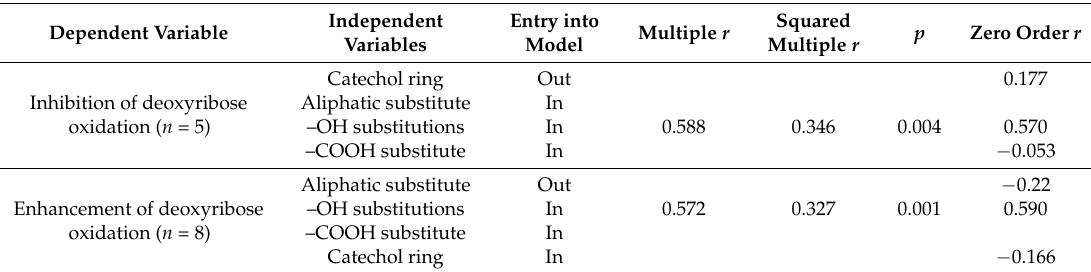
Table 3. Factors influencing the anti-oxidant and pro-oxidant properties of studied plant phenolics—a summary of multivariate